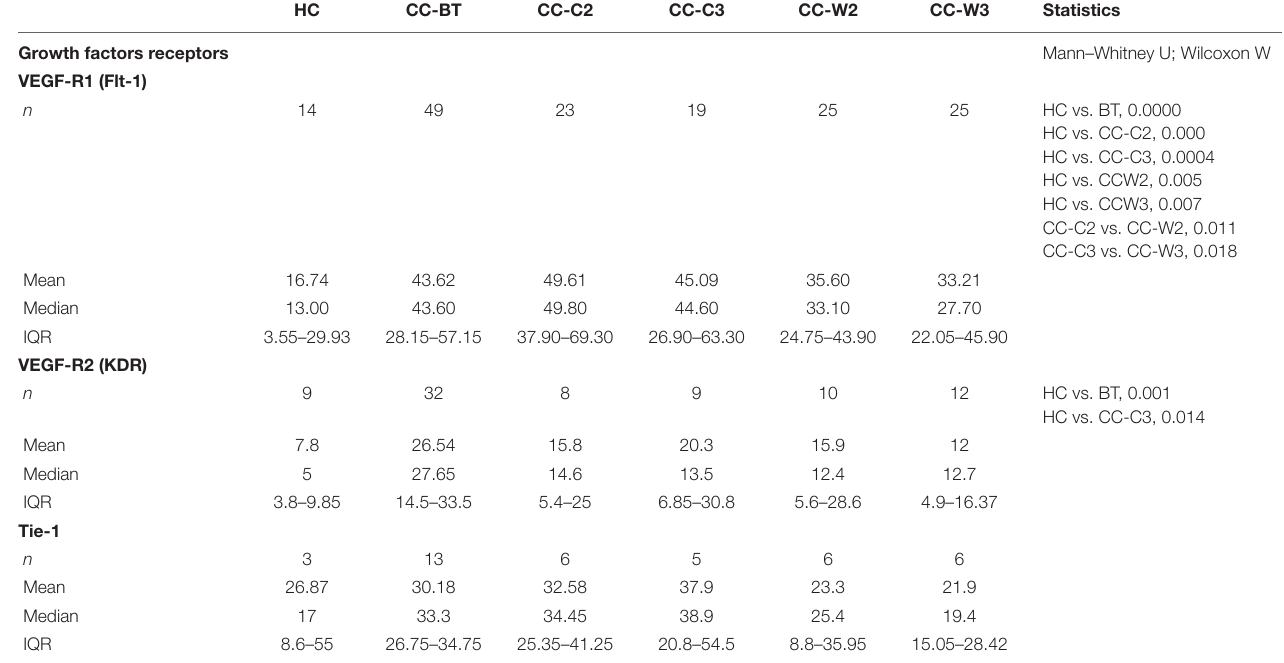
TABLE 4 | EVs growth factors receptors. HC CC-BT CC-C2 CC-C3